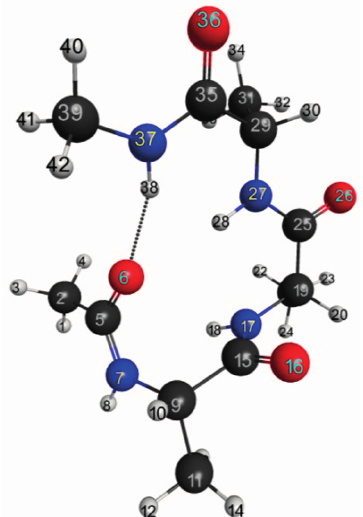
Figure 10. The selected geometry of the a-helix structure of trialanine peptide